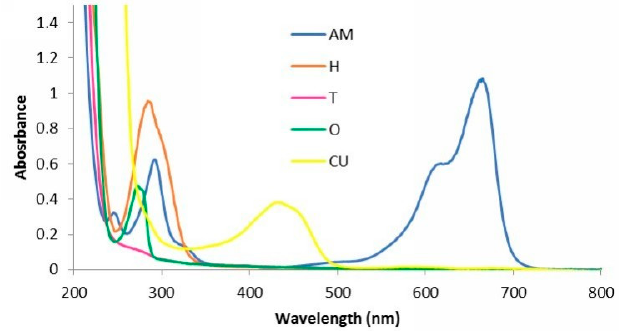
Figure 2. UV-VIS spectra of the experimental PS with AM, H, T, O and CU.